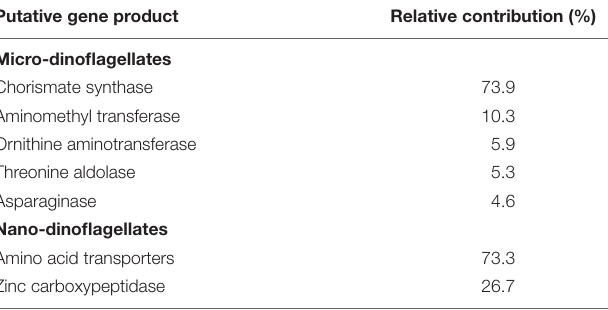
TABLE 2 | Most abundant, station specific genes involved in amino acid